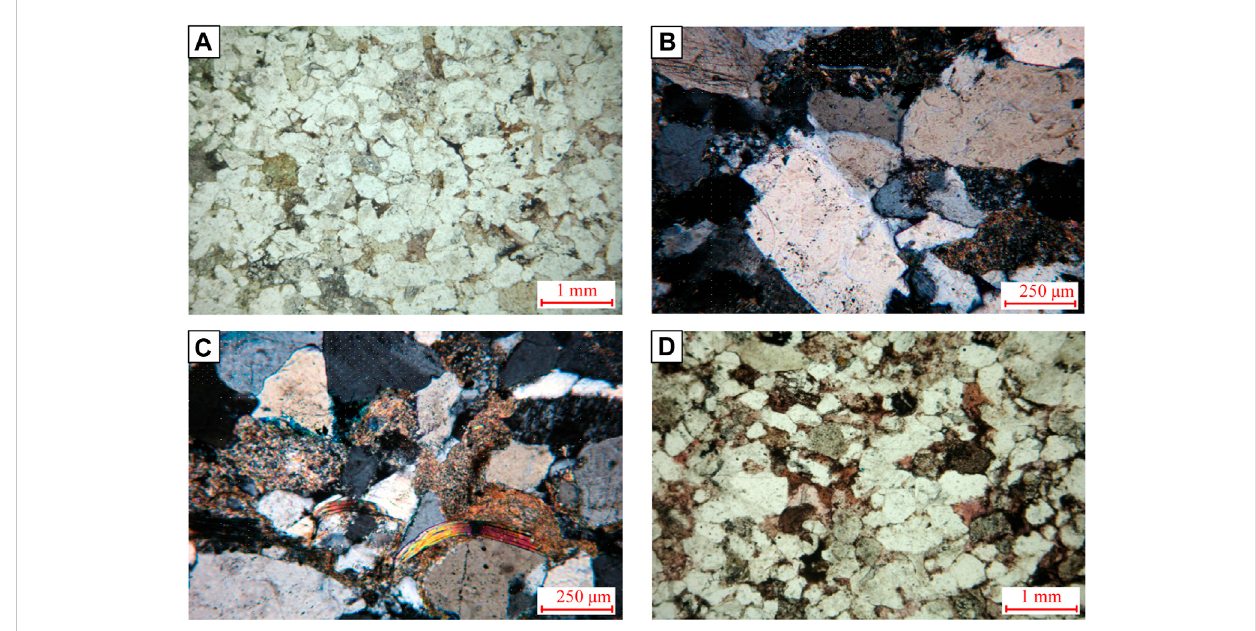
FIGURE 7 Microscopic characteristics of sandstone reservoir in overpressure section (A) The sandstone appears to have low porosity under the microscope, BY01-2987m; (B,C) Concave-linecontact betweenparticles, BY01-3025m; (D) A large amount ofcarbonatecements are fi lledbetween particles, BY02- 3231 m.